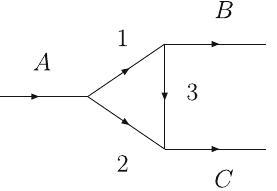
Fig. 1 Feynmandiagramfromwhereatrianglesingularitycanemerge. Particle A decays into 1 and 2, 1 decays into B and 3, and 2 and 3 merge to form particle